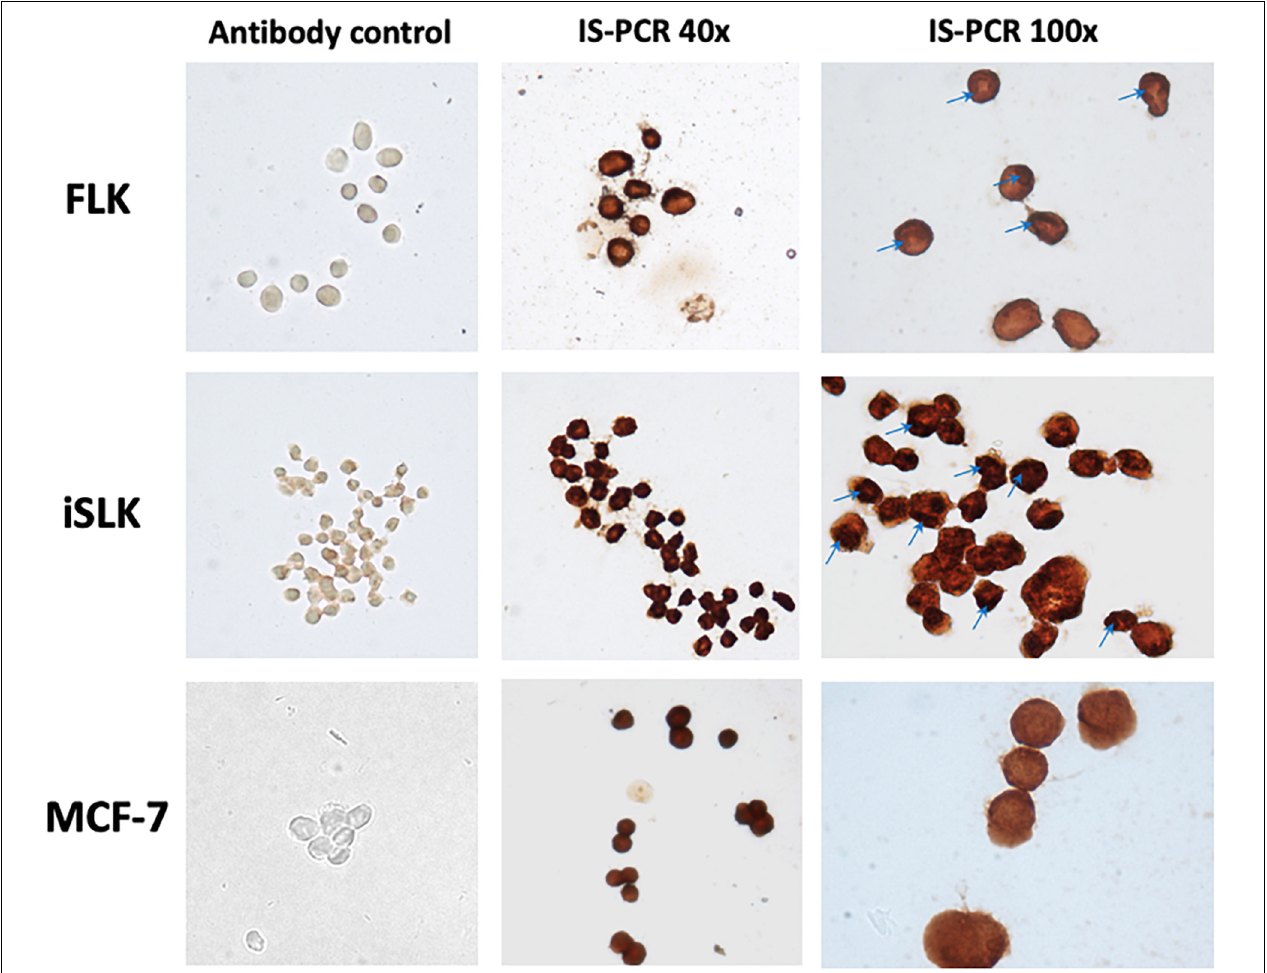
FIGURE 3 | Evidence of BLV inside the cells through in situ PCR ( tax region). Smear of infected cell lines. FLK—positive control cell line. iSLK-BLV positive (kidney). MCF-7 BLV positive (breast). Antibody control— in situ PCR without primers and TaqPolymerase control, verification of no cross-reaction of anti-dig antibody. In situ PCR with complete reaction. Stain is visualized by DAB reaction against anti-dig system. Images visualized at 40 × and 100 × on a Nikon Eclipse E200 optical microscope. All images were treated with the same conditions of color and